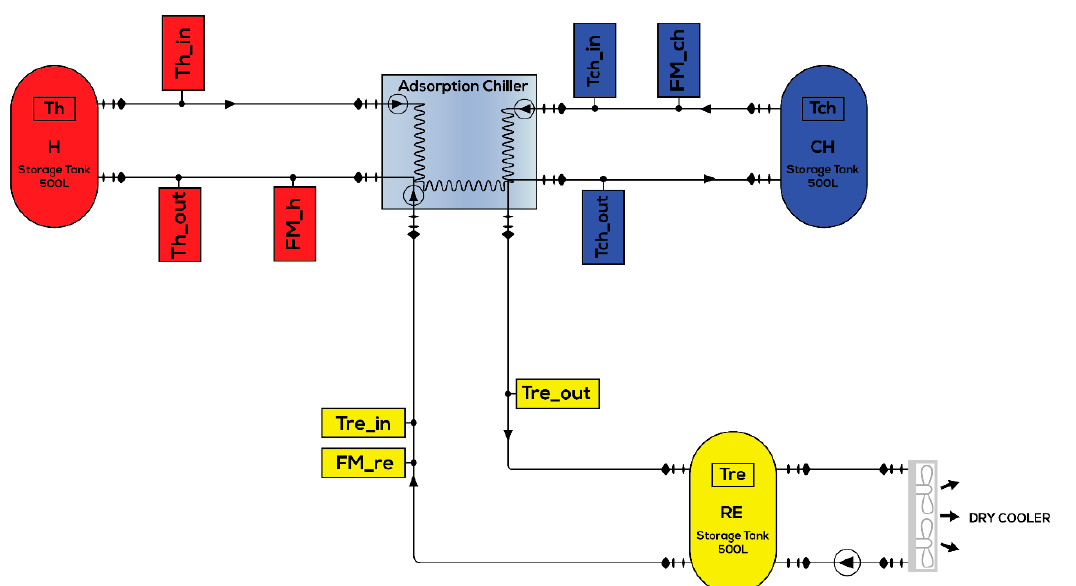
Figure 8. Schematic of prototype adsorption chiller testing equipment.